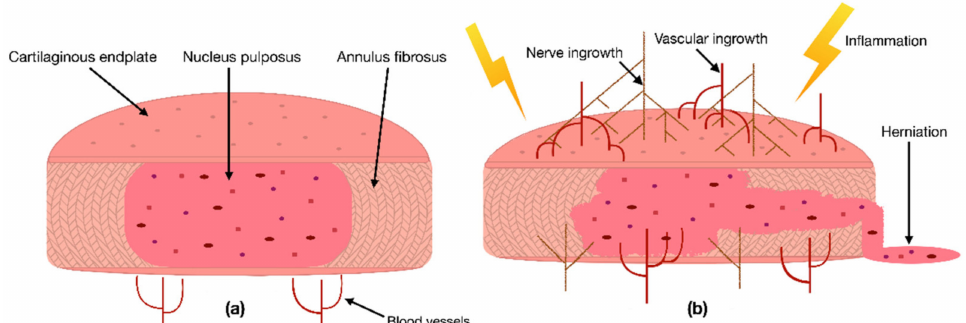
Figure 1. ( a ) Scheme of a cross-section of a healthy intervertebral disc (IVD) with its three tissue types: the nucleus pulposus (NP) in the center, surrounded by the annulus fibrosus and enclosed by two cartilaginous endplates. ( b ) Degenerated inflamed IVD characterized by nerve ingrowth, vascular ingrowth, reduced height, and herniation of the NP through the